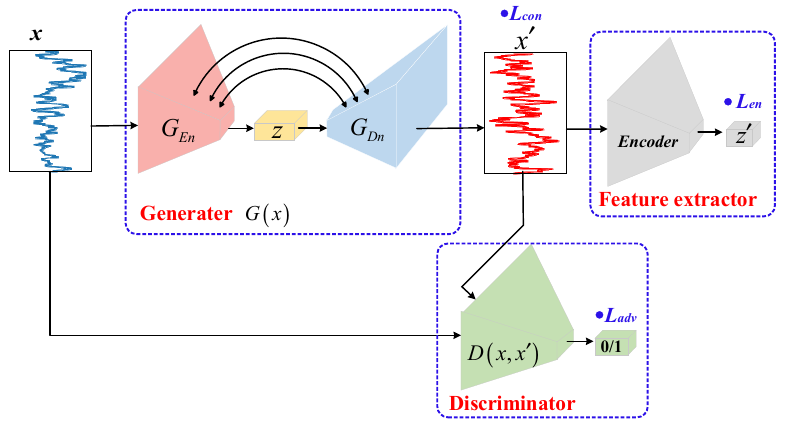
Figure 1. The pipeline of GANomaly model.